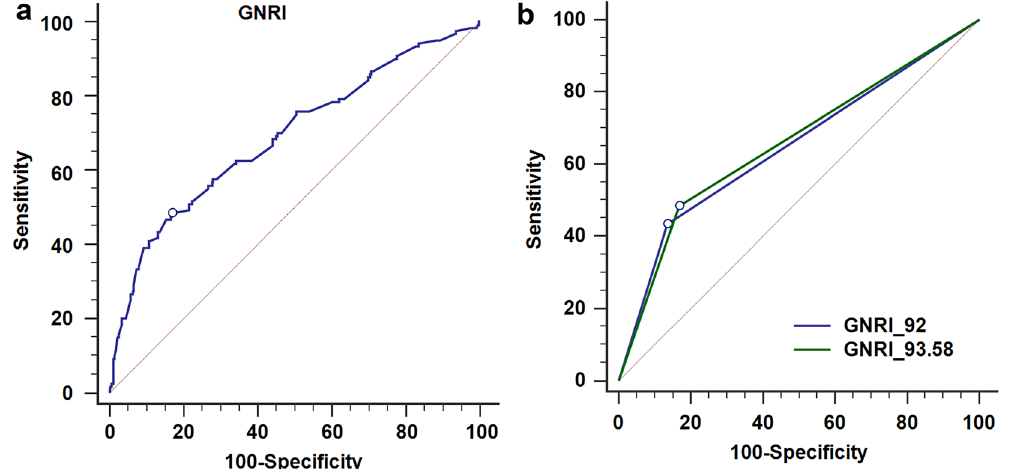
Figure 1. ROC for GNRI as a predictive factor for overall survival. The cut-off value was 93.58 with an AUC of 0.69 (sensitivity: 0.48, specificity: 0.83).